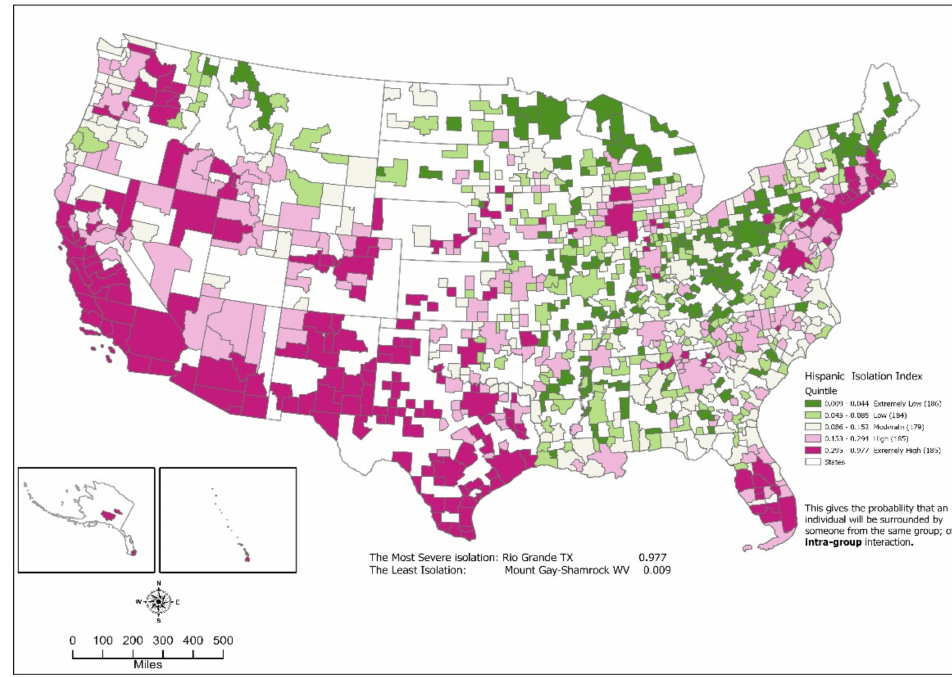
Figure 18. Hispanic Isolation Indices, Metro/Micro Areas, 2020. Native American Isolation Indices ranged from a low of 0.001 to a maximum of 0.861. The median index was 0.006, and the mean was 0.038. Metro areas had a median index of 0.388. The high was 0.773. Native Americans living in micro areas were less isolated, with a median index of 0.005, though the maximum micro area was 0.861. Overall, Native American Isolation Indices were low, with twenty-five percent having an index of 0.004 or less and twenty-five percent having an index of only 0.012 or greater. Geographically, the higher Native American Isolation Indices were clustered in the Southwest, the upper Plains, and the West (Figure 19). The highest index was for Show Low, Arizona, followed by Safford, Arizona, with indices of 0.861 and 0.860, respectively.